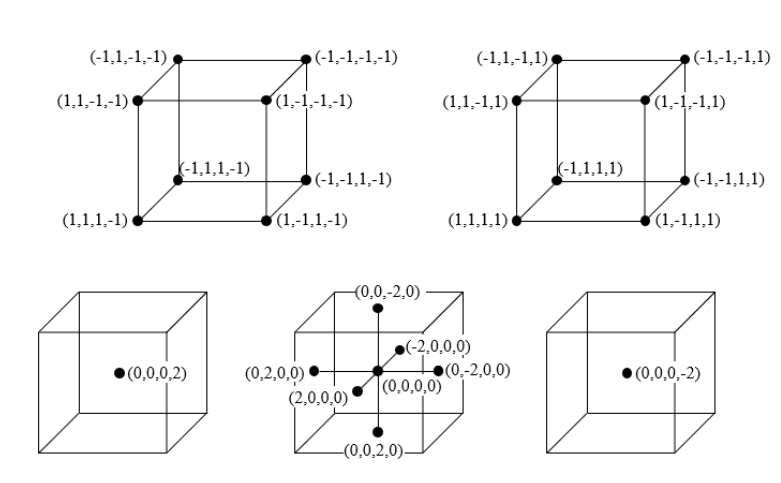
Figure 1. Experimental points in the experimental design, based on four independent